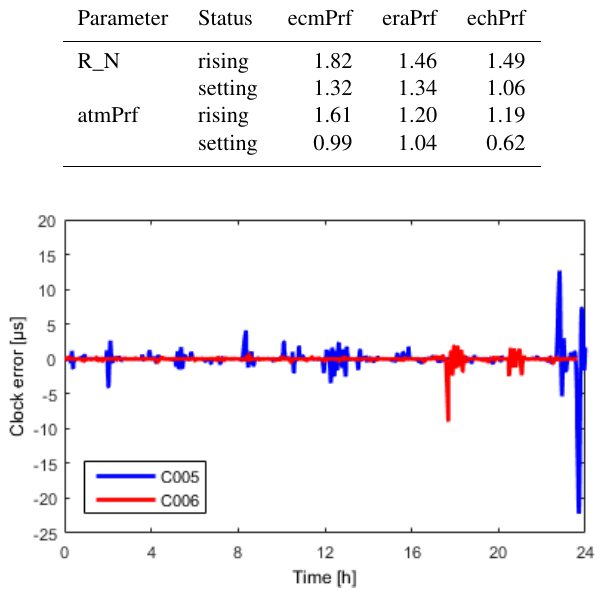
Figure 8. The 5th and 6th COSMIC receiver clock error on 12 De- cember 2013. C005 represents the 5th COSMIC RO satellite; C006 represents the 6th COSMIC RO